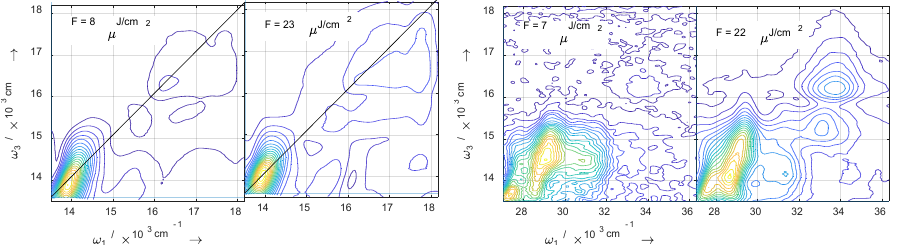
Fig. 2. Amplitude of evolution associated decay spectra (EADS, τ = 16 fs) of 3 rd (a) and 5 th (b) order signals at two different pulse energies indicated on the maps. Note the different ω 1 ranges in (a) and (b), indicating the selectivity for double excitonic states in 5 th order